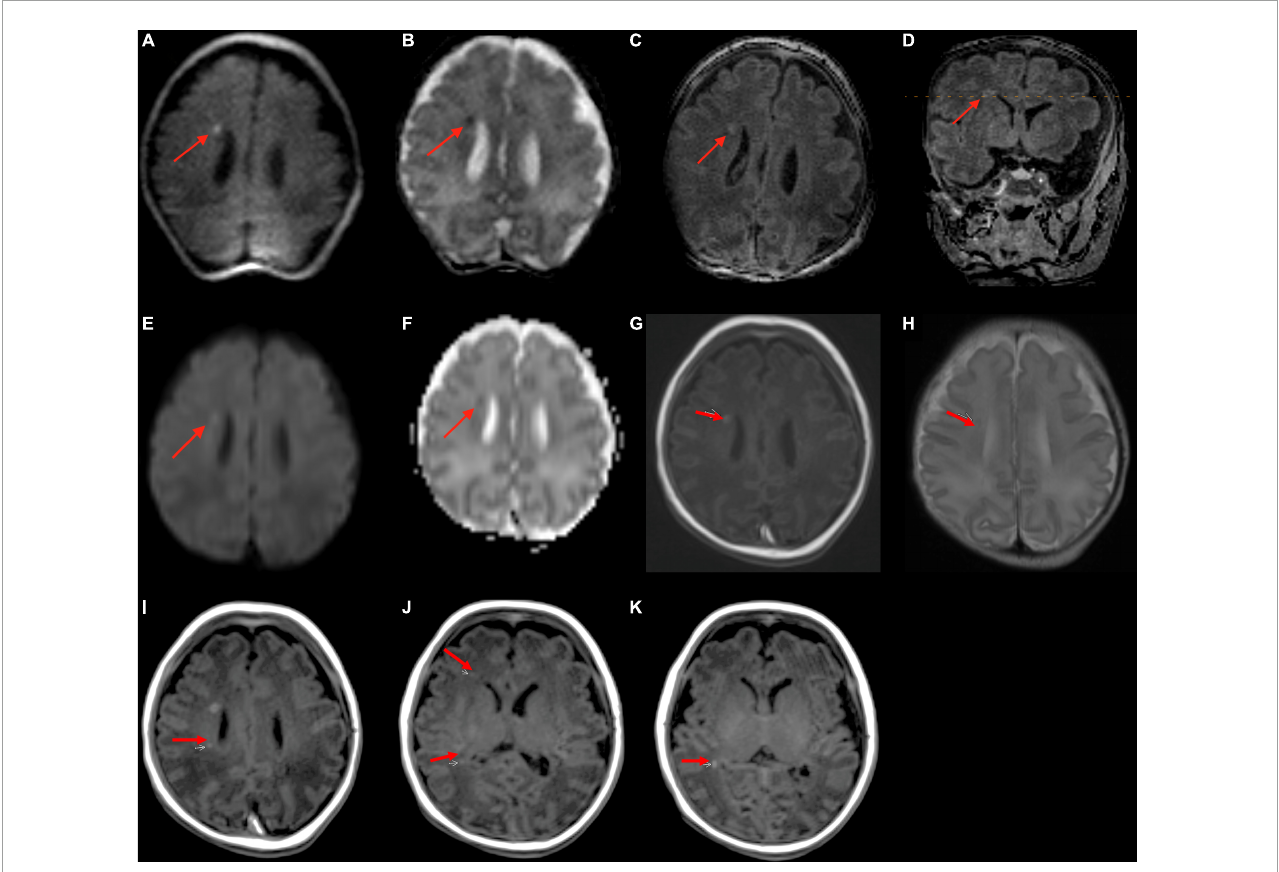
FIGURE2 In a 5-day-old infant with a history of delivery complicated by shoulder dystocia requiring respiratory support and chest compressions, the point-of-care 1-Tesla DWI (A) and ADC (B) showed a punctate focus of reduced diffusion with associated T1 hyperintensity (C,D) . Two days later, follow-up 3-Tesla MRI showed diffusion restriction (E,F) , T1 hyperintensity (G) , and T2 hypointensity (H) of the same lesion. There were four additional punctate foci of parenchymal injury with intrinsic T1 hyperintensity on 3-Tesla MRI (I–K) , which could not be visualized on preceding day 1-Tesla scan. No transcranial ultrasound was